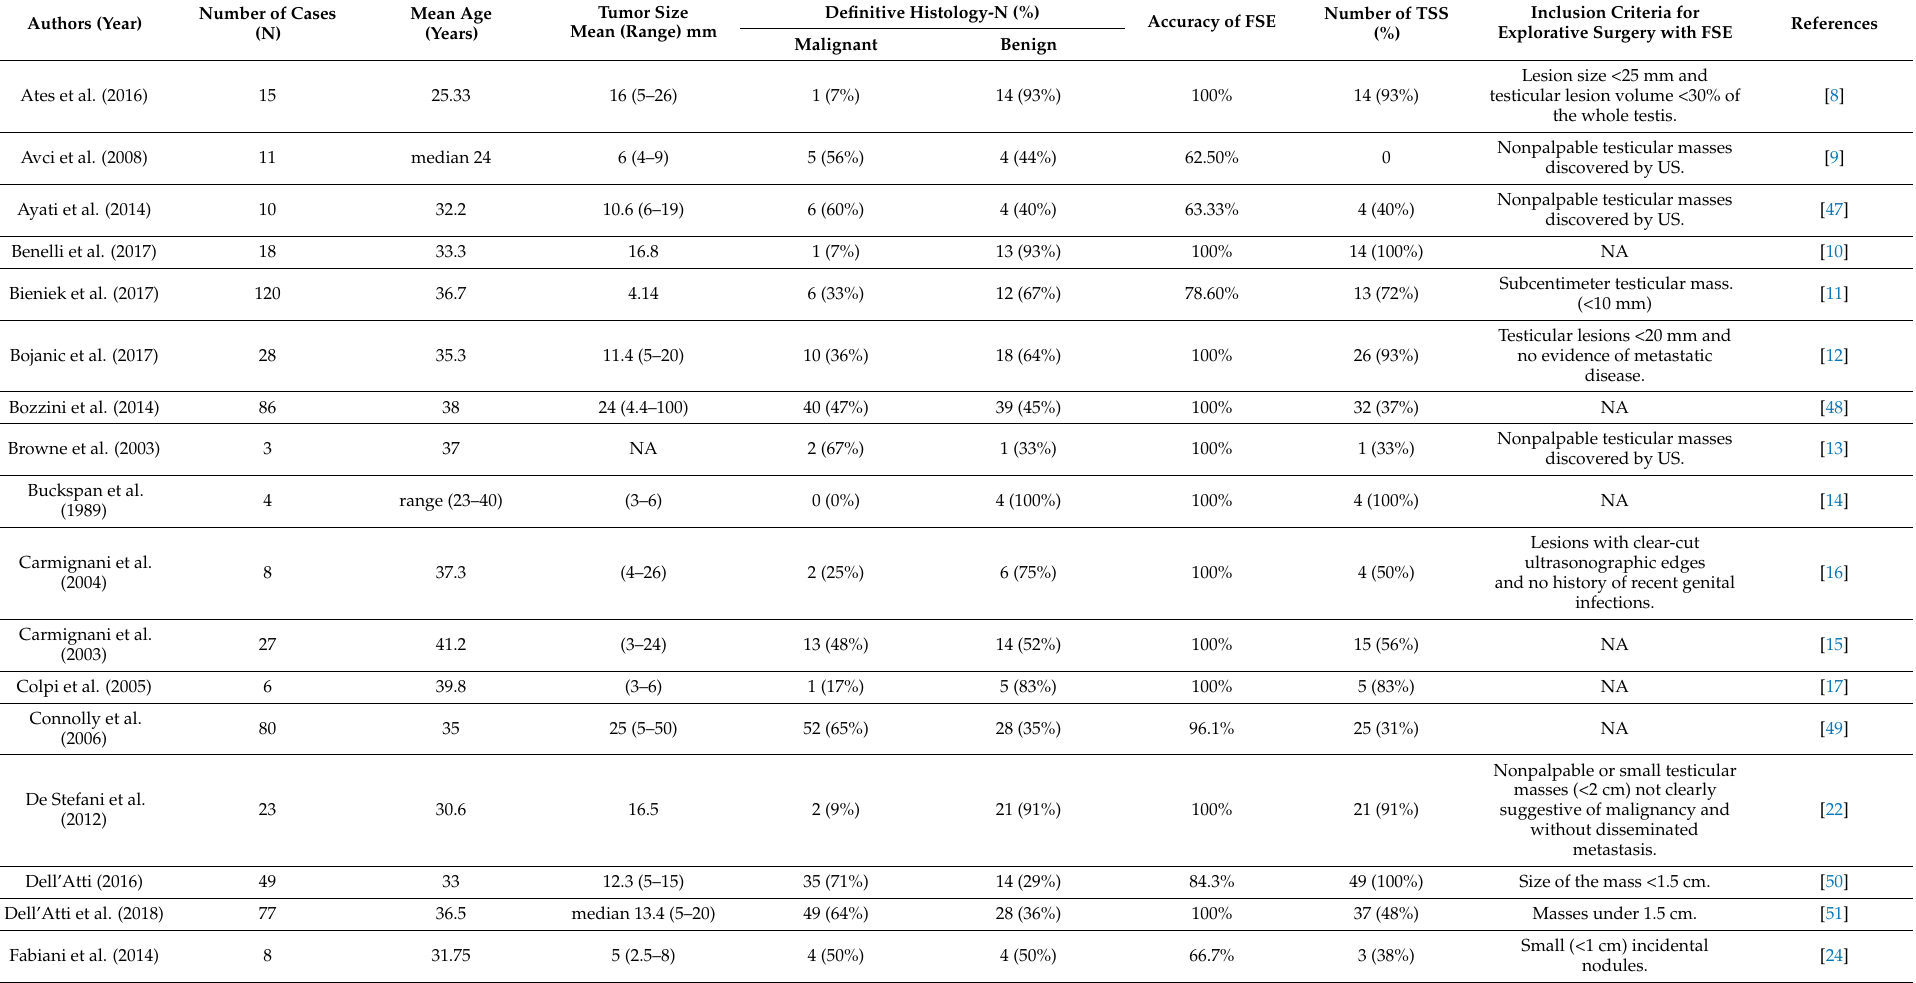
Table 3. Histology of STMs and accuracy of